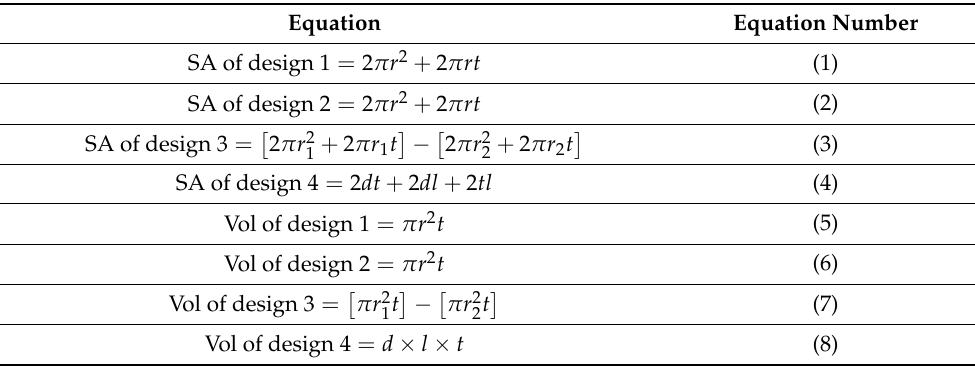
Table 2. Equations used to calculate the theoretical surface area (SA) and volume